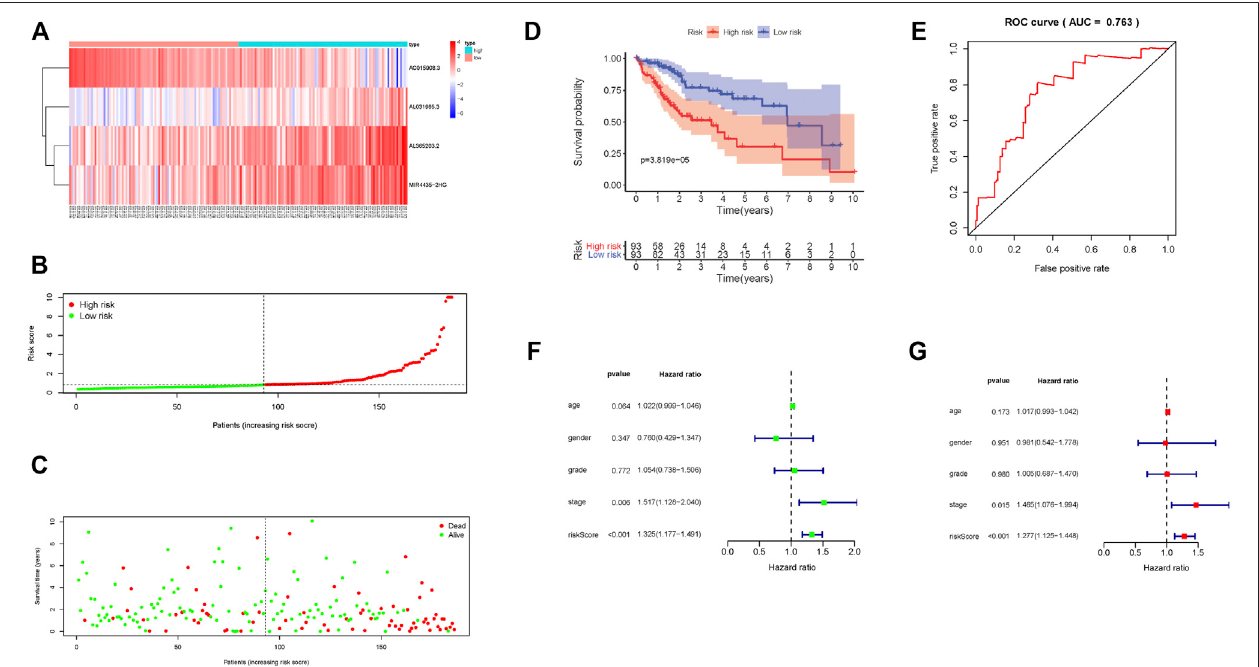
FIGURE 2 | Prognostic risk score characteristics of glycolysis-associated lncRNAs in the training set. (A) Heat map of the expression of four lncRNAs in HCC samples. The color from green to red indicates a trend from low expression to high expression. (B) . Distribution of risk scores for HCC samples. (C) The relationship betweensurvivaltimeand statusofHCCsamplesand riskscore. (D) Kaplan – Meiersurvivalcurveofsamplesinhigh-andlow-riskgroups. (E) ROCcurveofriskscorein samples with HCC. (F) Univariate Cox regression analysis of clinical features and risk score in HCC samples. (G) Multivariate Cox regression analysis of clinical features and risk score in HCC